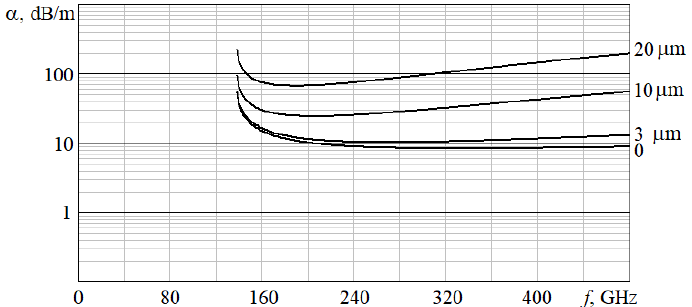
Fig. 5. Dependence on the frequency of losses per unit length in the rectangular waveguide with a cross section of 1.1 x 0.55 mm having a rectangular profile for a relative profile bearing length of 50